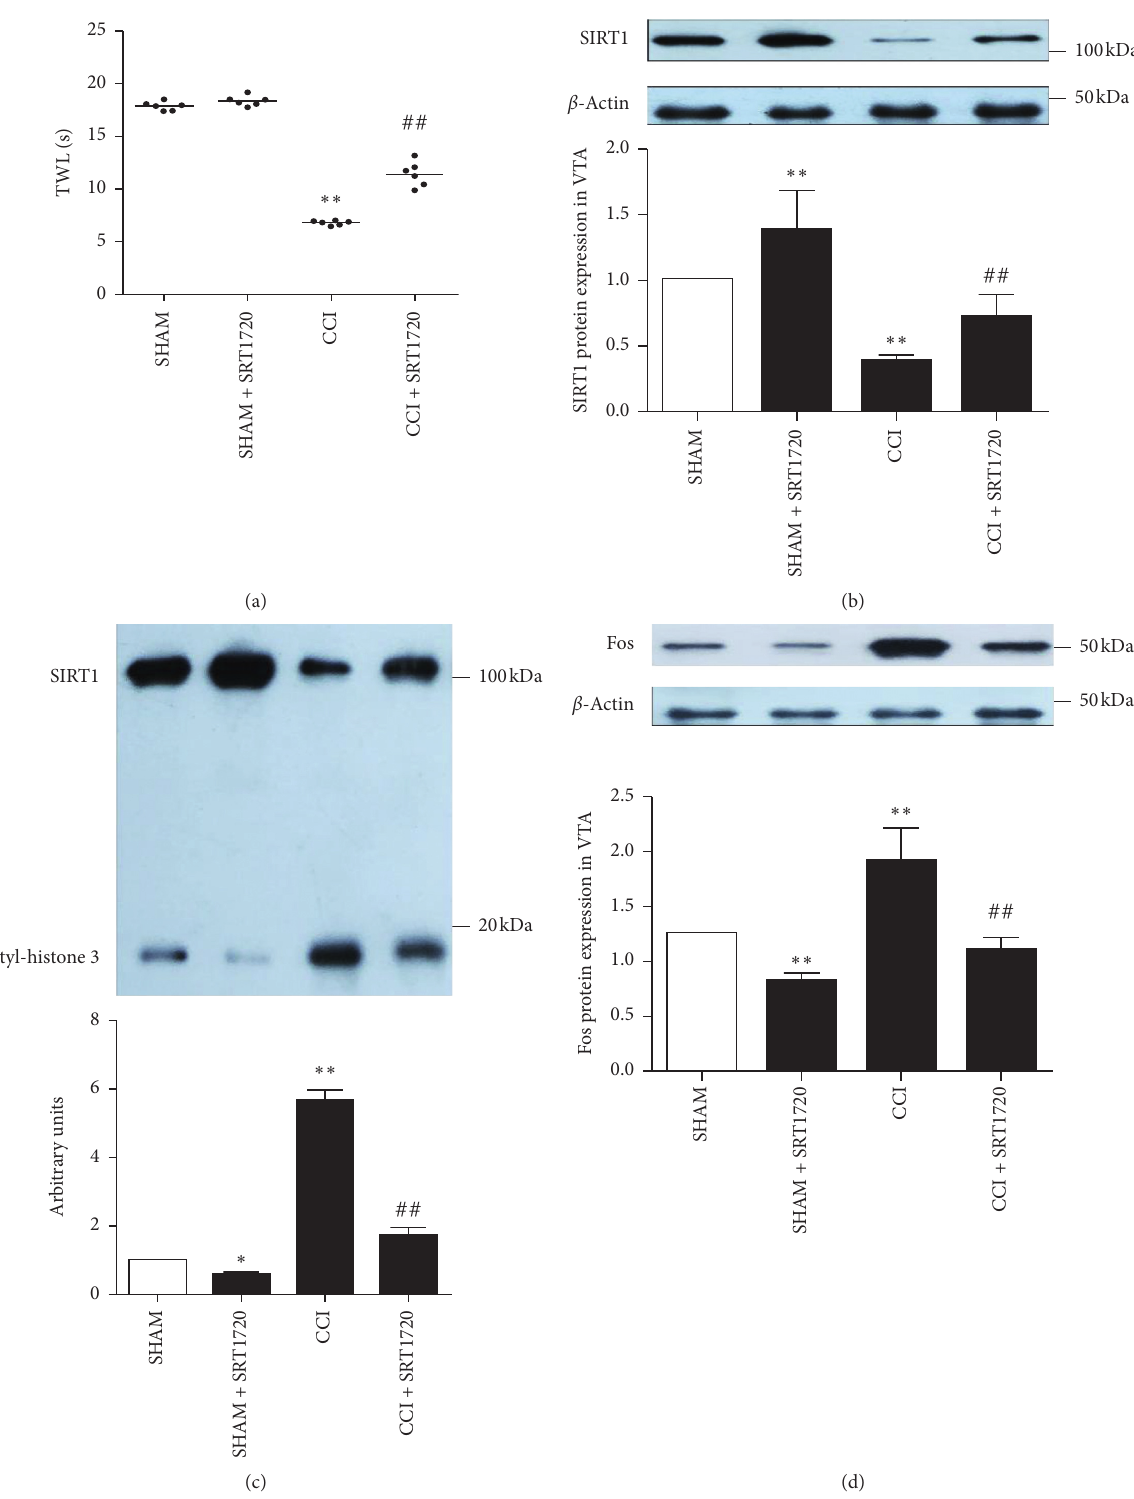
Figure 3: Effects of SRT1720 on pain behavior and VTA neuronal activation in CCI mice. CCI mice exhibited thermal hyperalgesia in the affected hind paws, which was relieved by SRT1720 (a). The expression of SIRT1 in the contralateral VTA was inhibited by CCI but upregulated by SRT1720 (b). The increased level of acetyl-histone 3 in the contralateral VTA induced by CCI was downregulated by SRT1720 (c). The increased expression of Fos in the contralateral VTA neurons induced by CCI was inhibited by SRT1720 (d). Data are presented as mean ± SD. n � 6 mice per group ( n � 3 in the coimmunoprecipitation experiment). ∗ P < 0 . 05, ∗∗ P < 0 . 01 versus the sham-operated group, # P < 0 . 05, and ## P < 0 . 01 versus the CCI